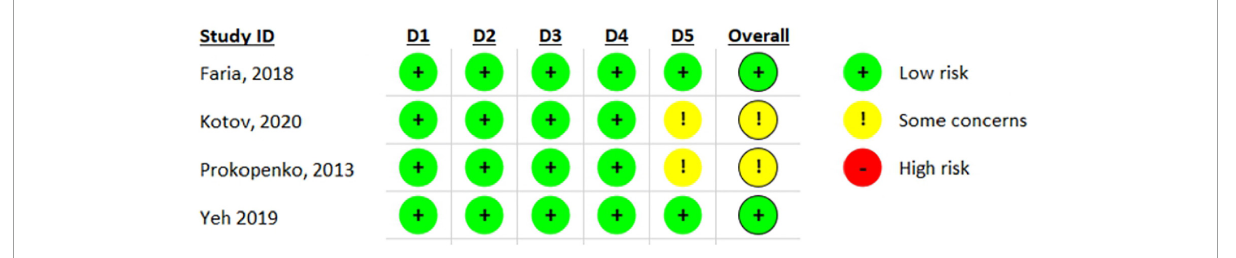
FIGURE2 Risk of bias analysis with individual results for each domain of included studies through RoB 2.0.